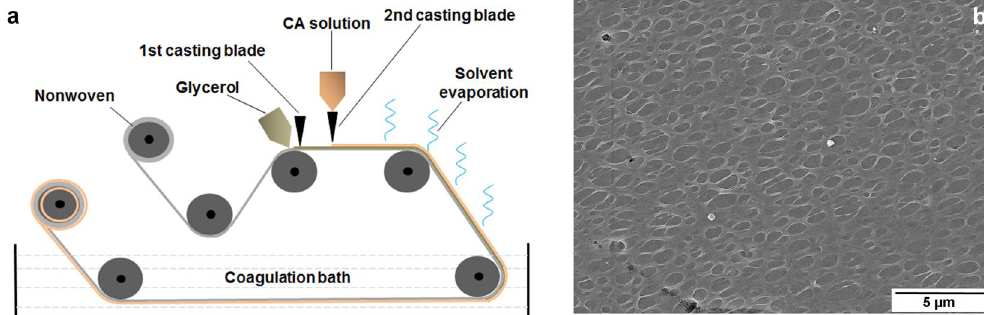
Figure 6. ( a ) Casting machine equipped with two casting blades; first one is for glycerol and the second one is for the film forming solution. ( b ) SEM image of the surface of the film casted with the machine depicted in (a) by using 8% CA solution in